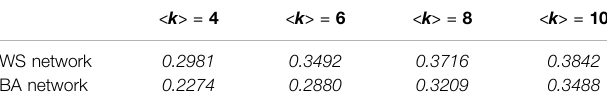
TABLE 1 | The robustness of the Watts – Strogatz (WS) and Barabási – Albert (BA) networks with different < k > values at the steady state ( T (cid:1)